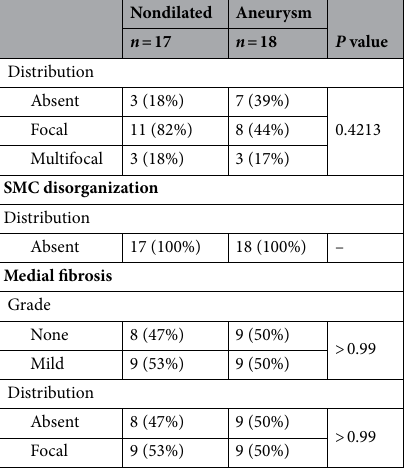
Table 2. Qualitative histopathological scoring of medial degeneration. Qualitative (semiquantitative) scoring of medial degeneration by an experienced pathologist of ascending aorta specimens from organ donors (nondilated) and patients undergoing aneurysm repair (aneurysm). The specimens were assessed blinded to the clinical diagnosis. Diagnostic criteria include overall medial degeneration score and several individual components of medial degeneration categorized by grade and distribution (subcategories without scores are not shown). Categorical variables are represented as score totals and percentage of total subjects and comparisons of the criteria with multiple subcategory scores are by Fisher’s exact